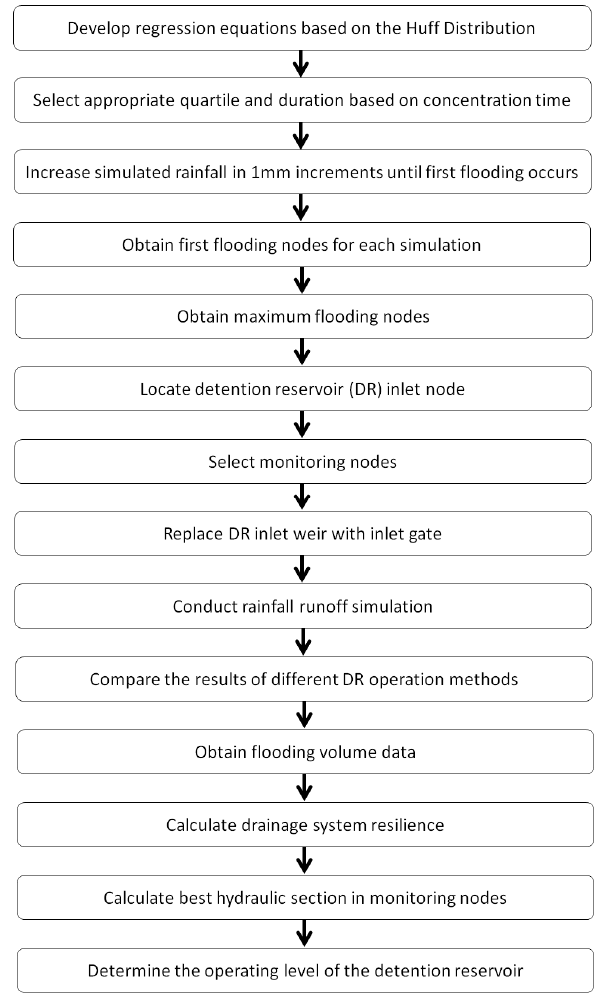
Figure 1. Flowchart for new detention reservoir (DR) operation and inlet design.